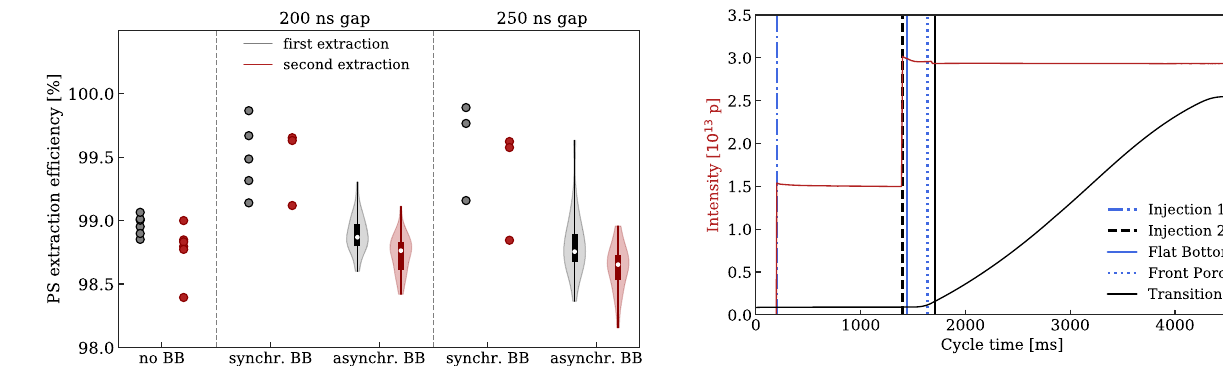
13. PS relative extraction efficiency measured during